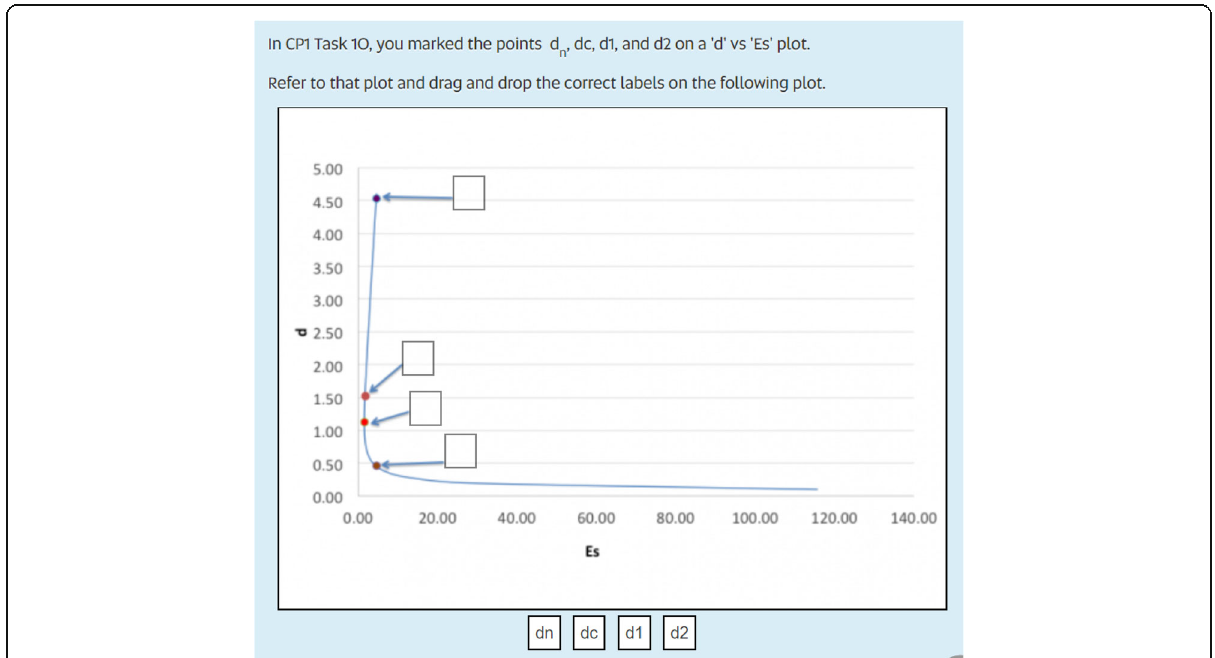
Fig. 5 A Moodle question where students must identify the points by dragging and dropping